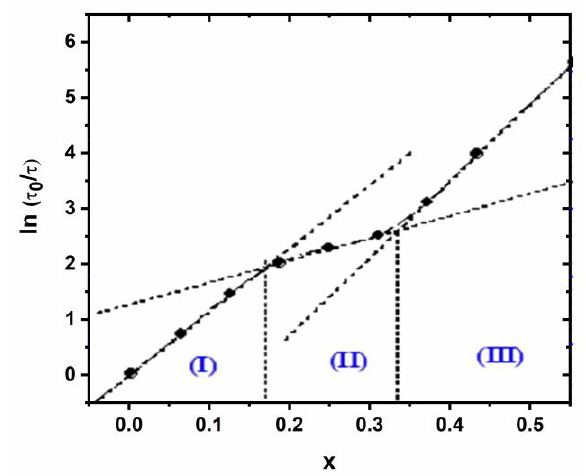
Figure 12. Variation of ln (τ/τ0) as a function of (x).